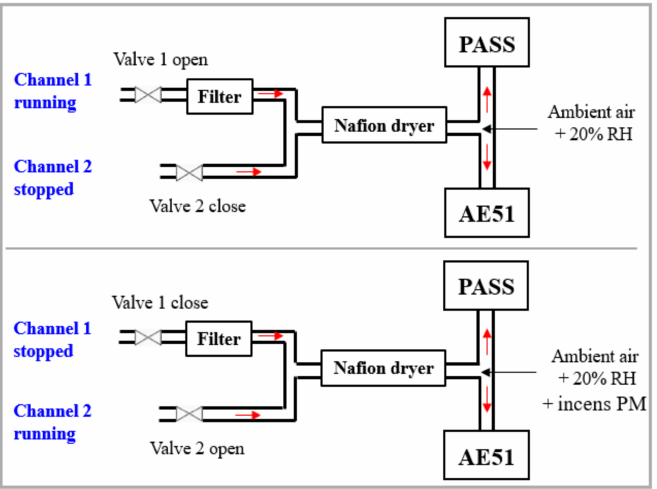
Figure 6. Schematic representation of the 2-channel measurement approach.